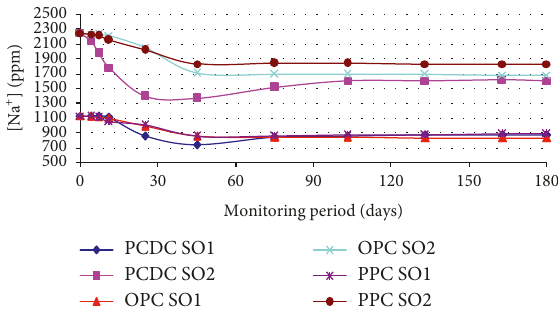
Figure 12: Na + analyses from simulated sulphate solutions.